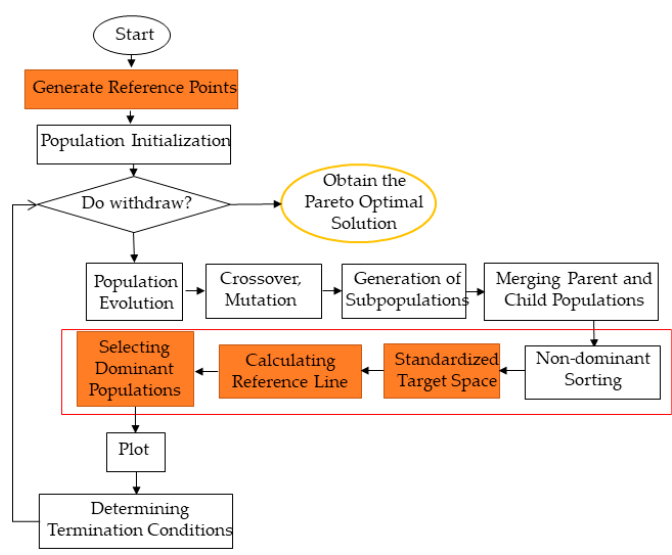
Figure 7. NSGA ‐ III algorithm main flowchart. Figure 7. NSGA-III algorithm main